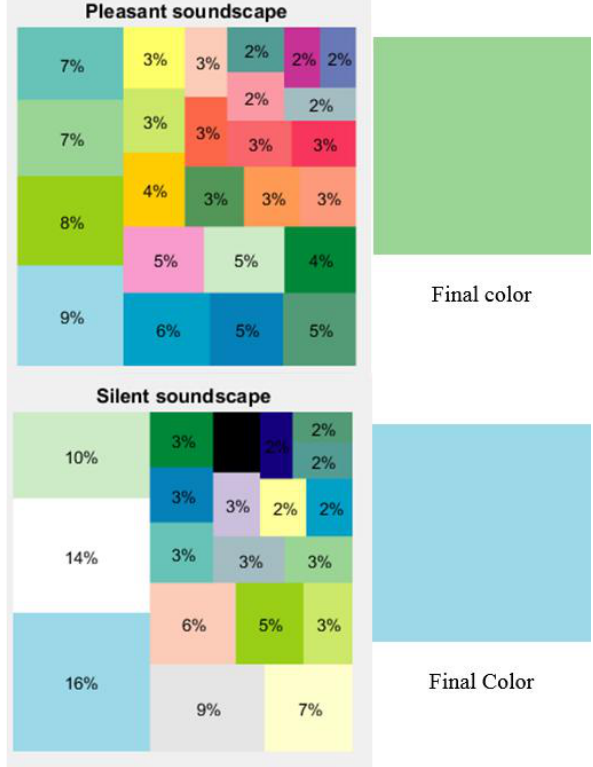
Figure 13: Results of the Internet color study for a pleasant sound- scape and for a silent soundscape.